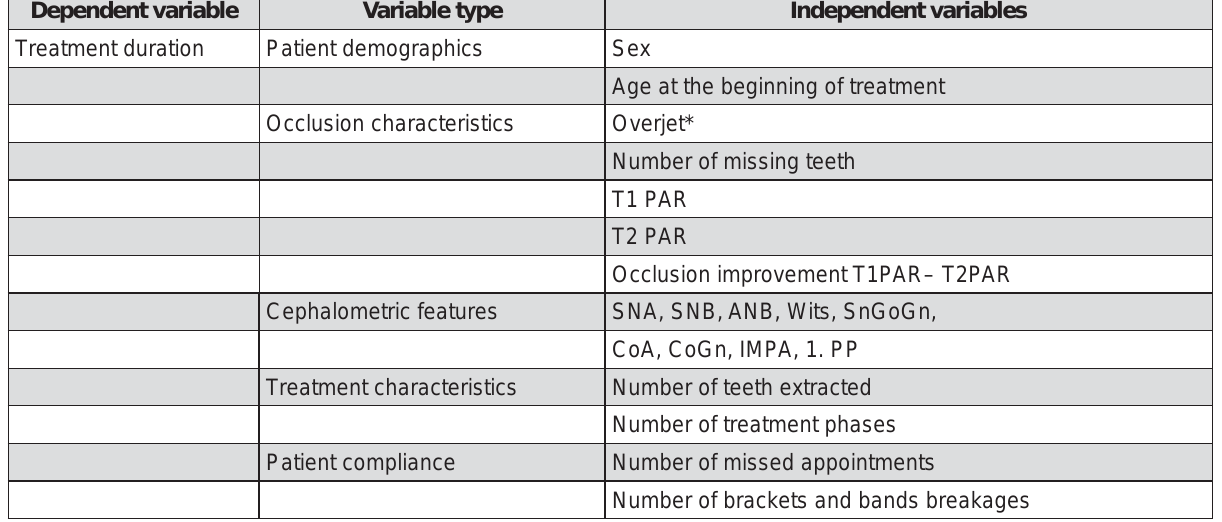
Figure 1- Variables analyzed in the